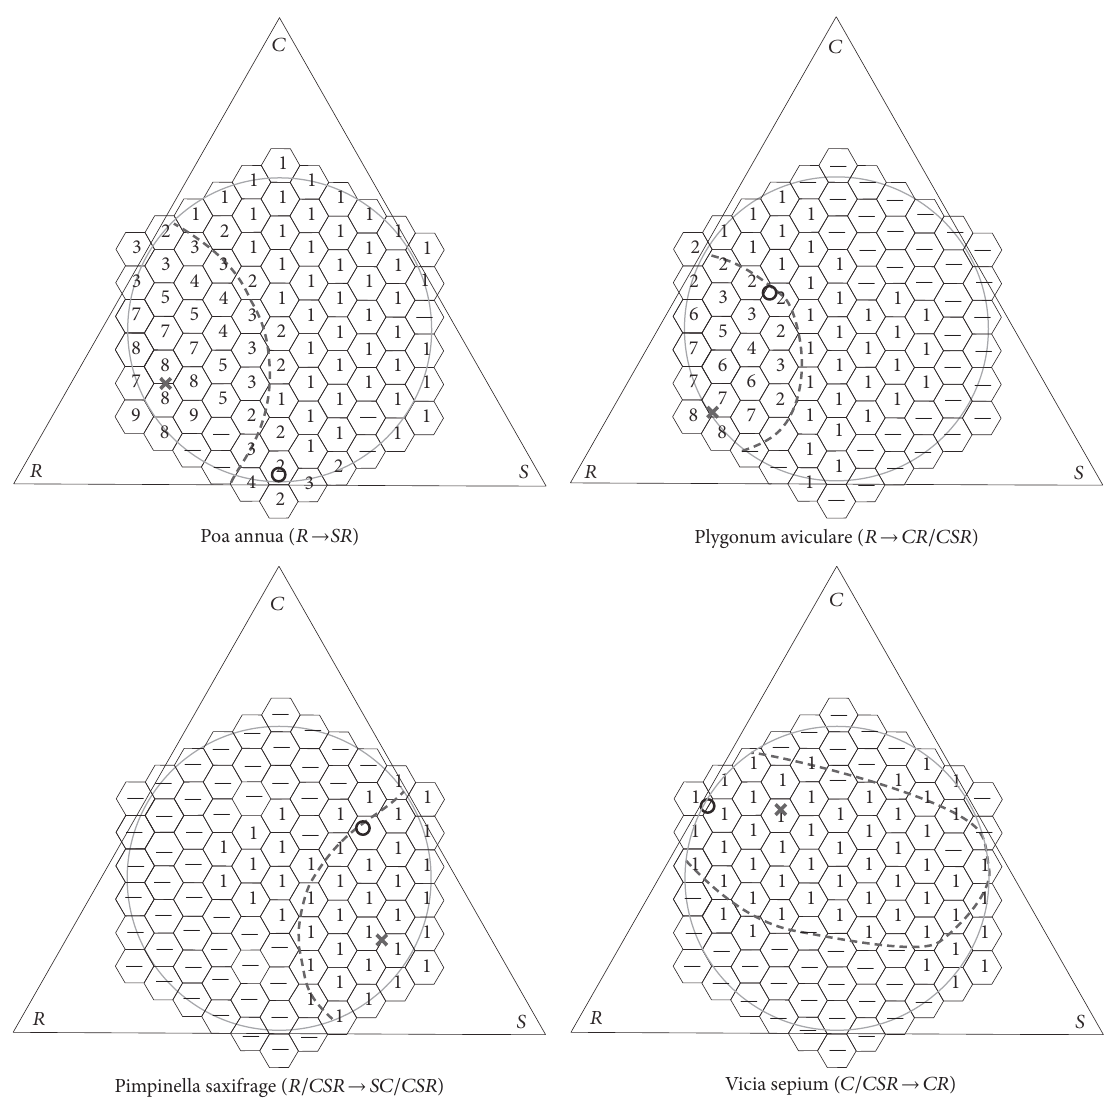
Figure 5: Allocation of species in Grime’s triangle. Crosses, reference plant functional type according to Grime; noughts, functional type, revealed by our model; dotted line, potential area of changes of the plant functional type (“area of variability”). Figures are taken from [2] with add-ons. Species with the largest deviation from reference position were selected (distance